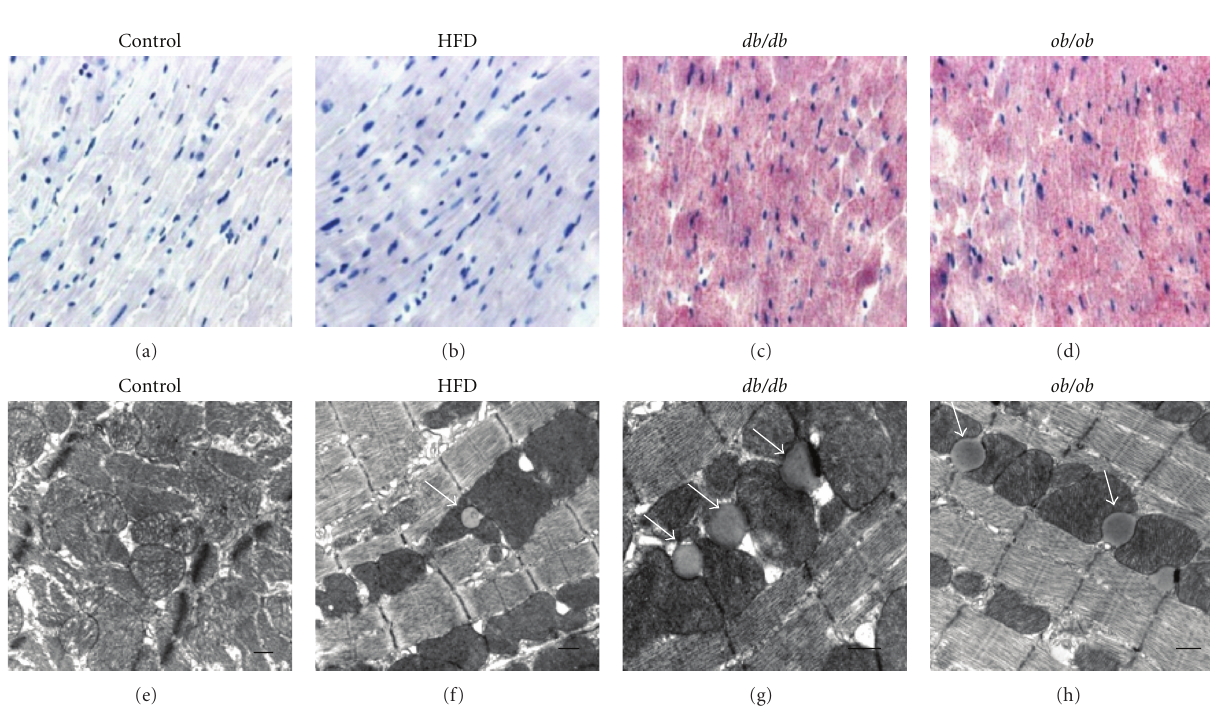
AW: anterior wall thickness. PW: posterior wall thickness. LVEDD: left ventricular end diastolic dimension. LVESD: left ventricular end systolic dimension. LVM: left ventricular mass. %EF: percent ejection fraction.